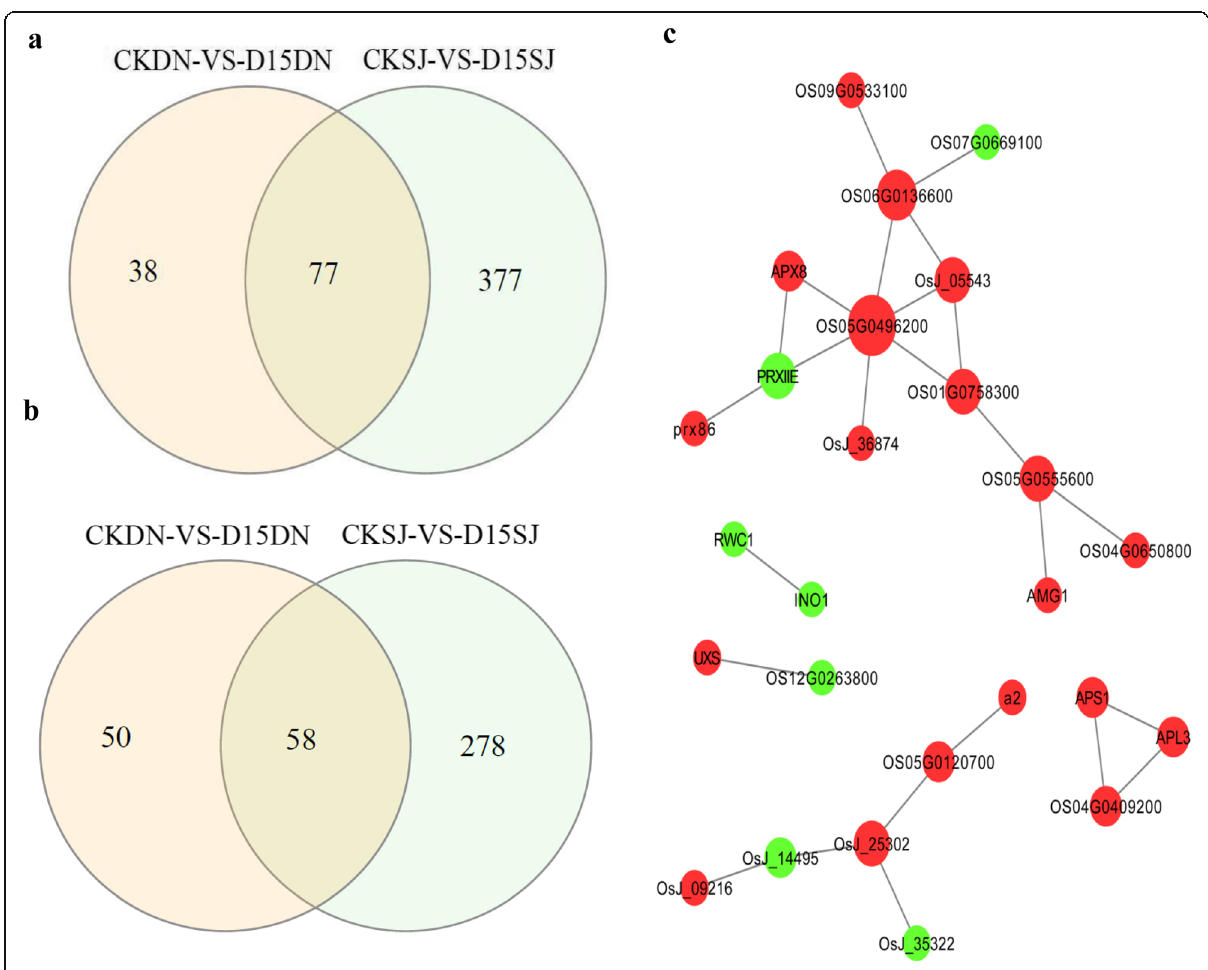
Fig. 5 Comparative proteome analysis of the rice cultivars revealed cold tolerance mechanisms. a, Venn diagram of the downregulated differentially expressed proteins in Dongnong428 (DN) under control (CKDN) vs. DN under low-T w (D15DN) and Songjing10 (SJ) CKSJ vs. D15SJ. b, Venn diagram of the upregulated differentially expressed proteins in CKDN vs. D15DN and CKSJ vs. D15SJ. c, Protein-protein interaction analysis of the specific CKSJ vs. D15SJ differentially expressed genes, performed using